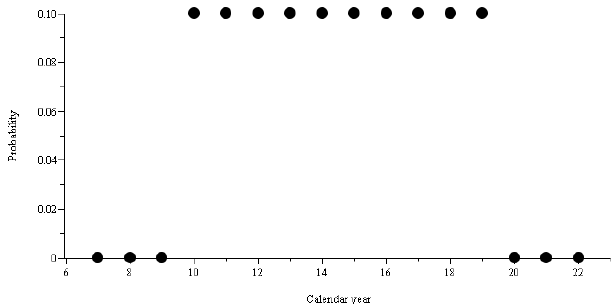
Fig. 6. Calibration graph of a sample whose radiocarbon age is ex- actly 100 14 C BP (via the calibration curve in Fig. 5).